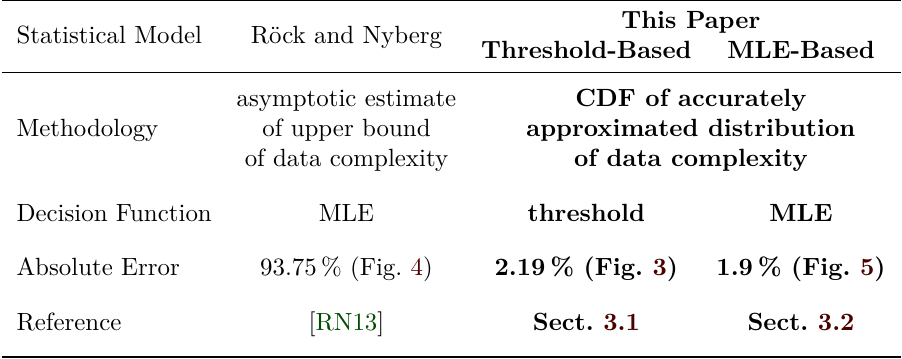
Table 1: Comparison of Statistical Models involved in this paper. As our experiments show in Appendix F, our MLE-based model is slightly more precise but much slower to compute, compared to the threshold-based